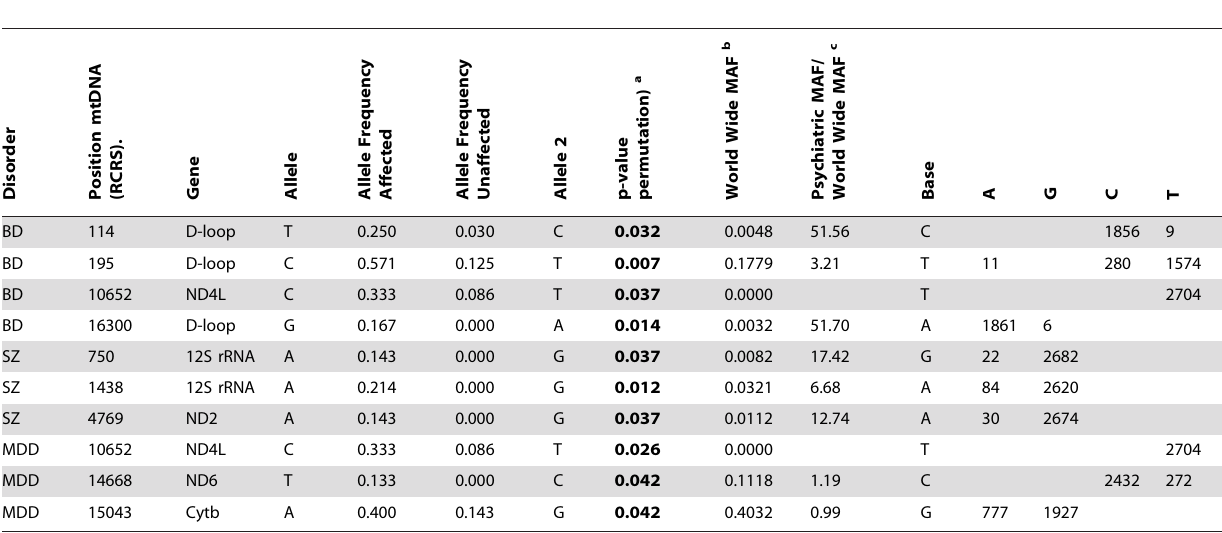
Table 3. Mitochondrial polymorphisms were analyzed in PLINK for allelic association with 50,000 case-control permutations to obtain empirical p-values.